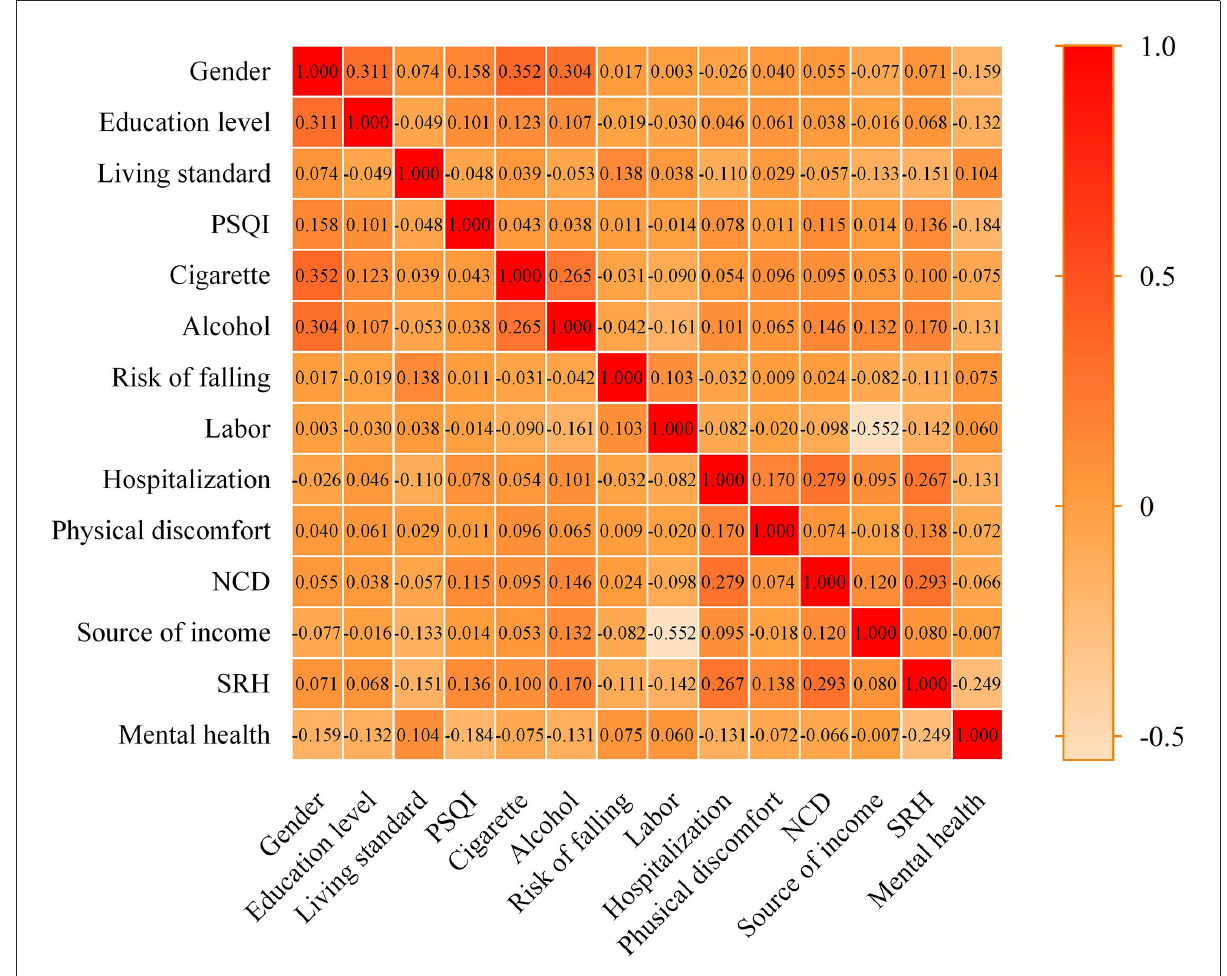
FIGURE1 Correlation between